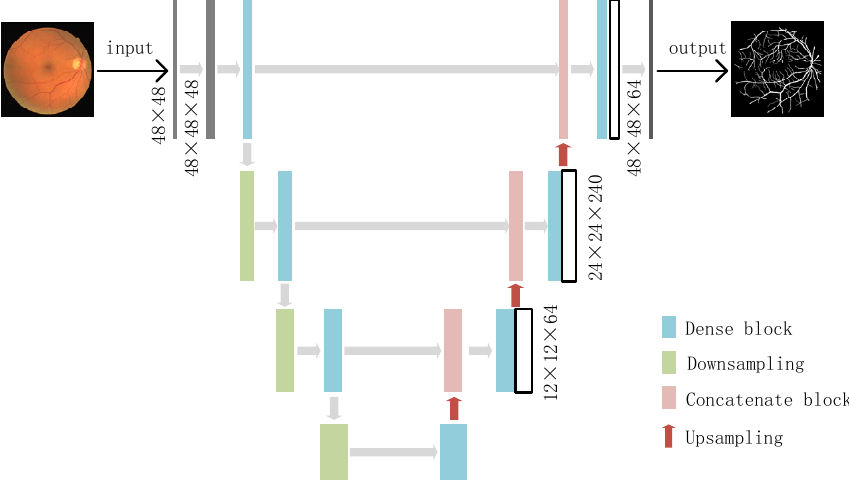
Figure 4. Dense-U-Net model .